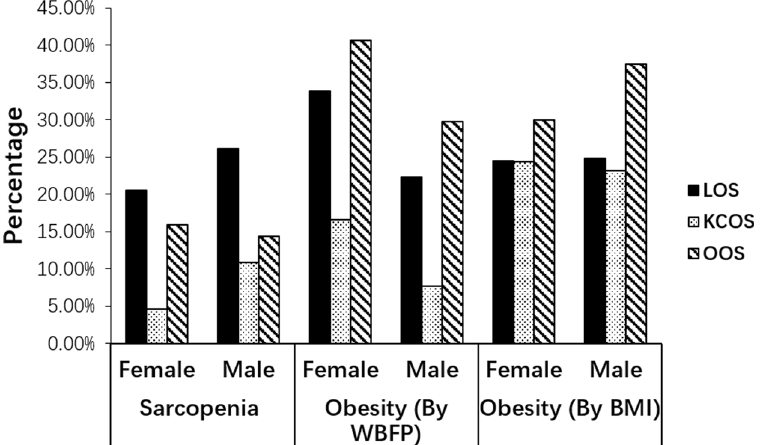
Figure 1. Prevalence of sarcopenia and obesity in subjects from LOS, KCOS, and OOS. The sex-specific cutoff values for sarcopenia are 7.26 kg/m 2 (male) and 5.45 kg/m 2 (female). Using BMI value, obesity was defined as BMI ≥ 30 kg/m 2 . Using WBFP, the cutoff points of 30% and 40% were proposed for males and females,